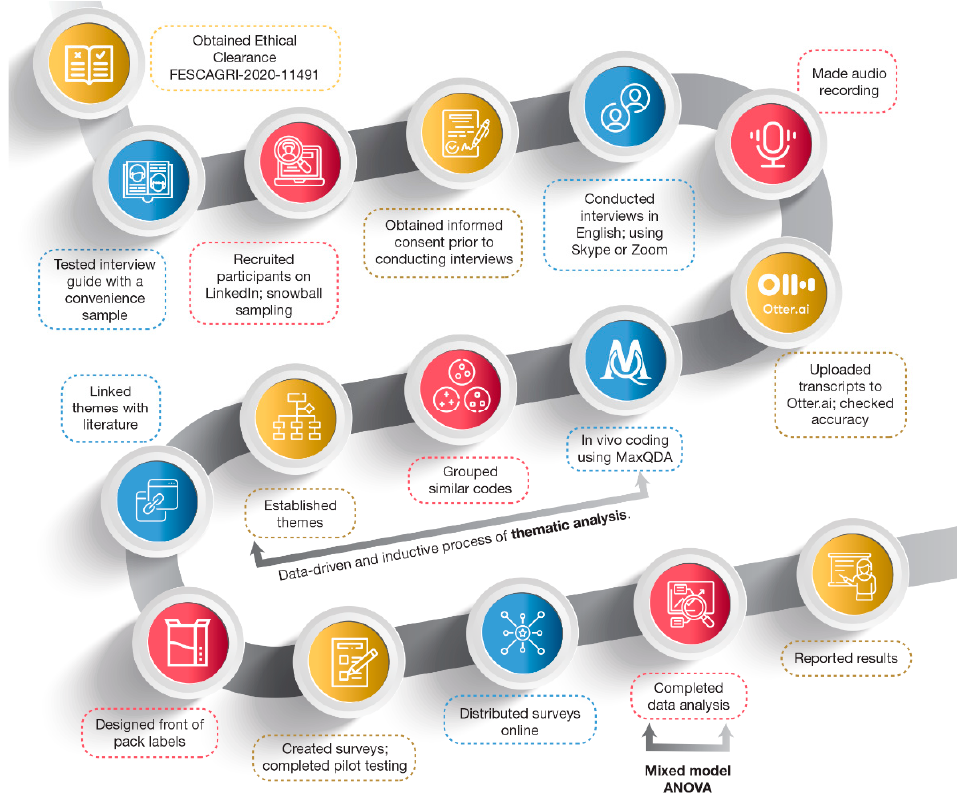
Figure 1. Exploratory mixed-methods sequential study process (ANOVA: Analysis of variance).